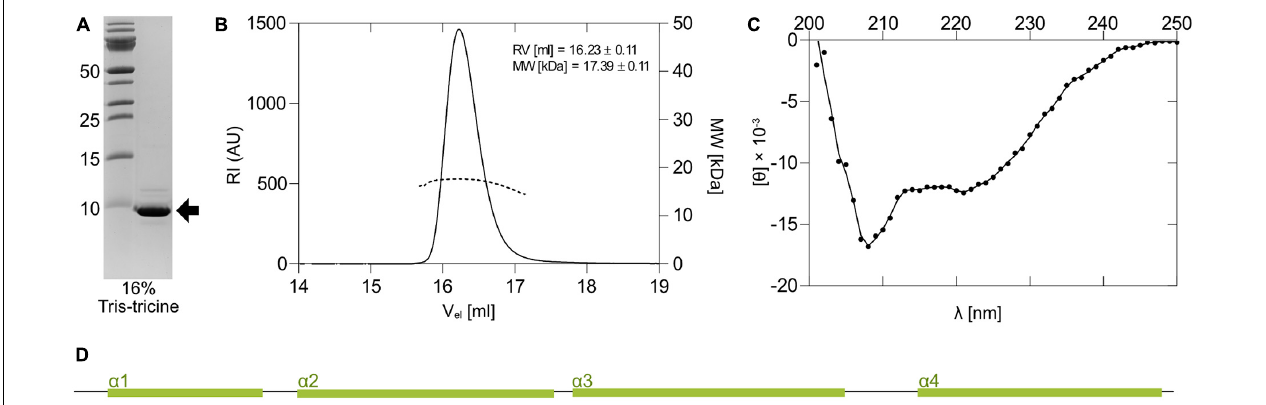
FIGURE 4 | Expression and properties of the 1067 antitoxin. (A) The 1067 antitoxin was overexpressed in E. coli as a C-terminally His-tagged protein and isolated by nickel-affinity chromatography. It migrated on a 16% Tris-tricine gel with an approximate molecular weight of slightly less than 10 kDa (black arrow). (B) Right and Low Light Scattering (RALS/LALS) showed that the antitoxin in solution was mostly present as a molecule with an approximate size of 17.4 kDa, indicating the formation of a dimeric structure. (C) The CD spectrum of the 1067 antitoxin in 20 mM HEPES, pH 7.4, showed that at 25 ◦ C it exhibited predominantly α -helical structure. This was further confirmed by secondary and tertiary structure prediction models (D) , which predicted the folding of the protein into four α -helices. The clusters with two or more Arg residues are marked in